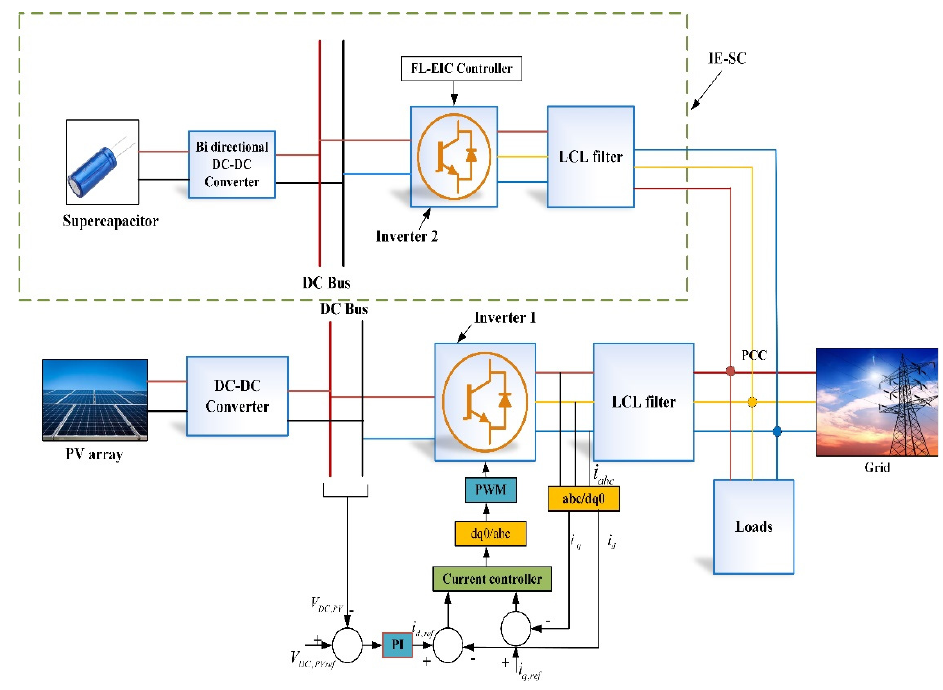
Figure 2. System configuration of a proposed system connected to a low inertia grid.